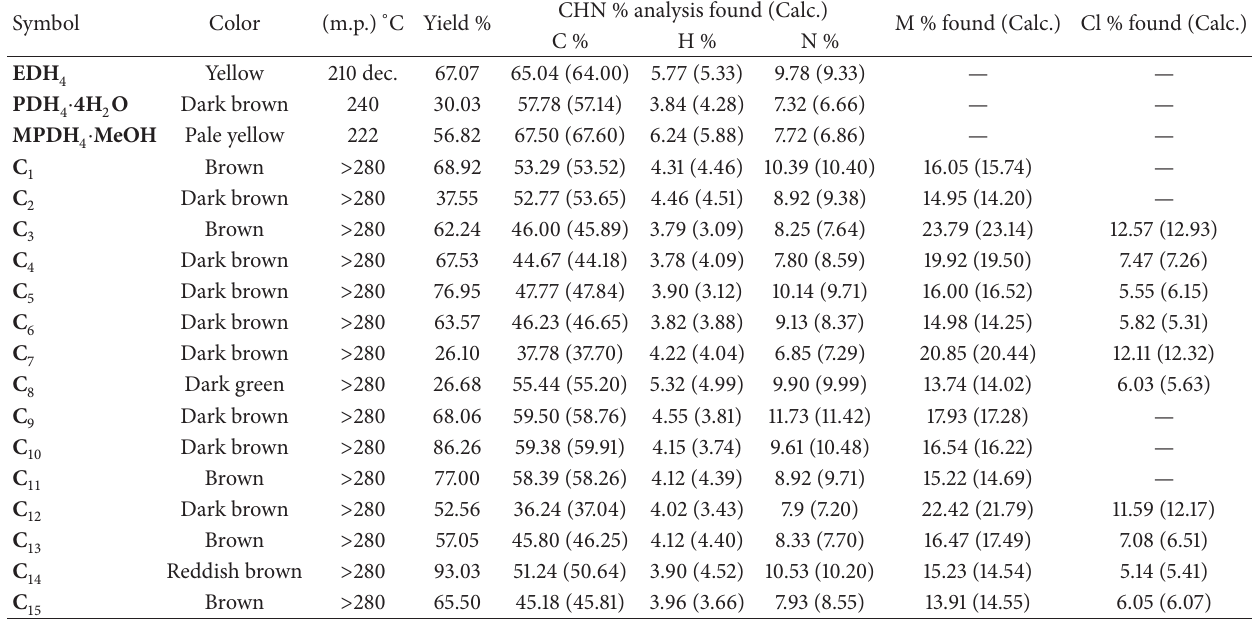
Table 1: The physical properties and analytical data for Schiff bases and their metal complexes.